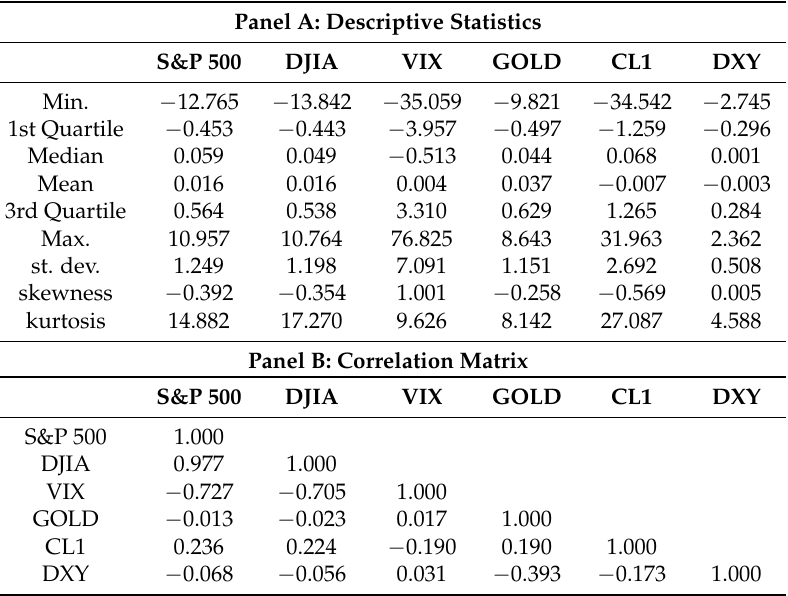
Table 3. Descriptive statistics (Panel A) and correlation matrix (Panel B) of the variables used in the study. The data consist of log-returns (multiplied by 100) for the period of January 2001–April 2020. Panel A: Descriptive